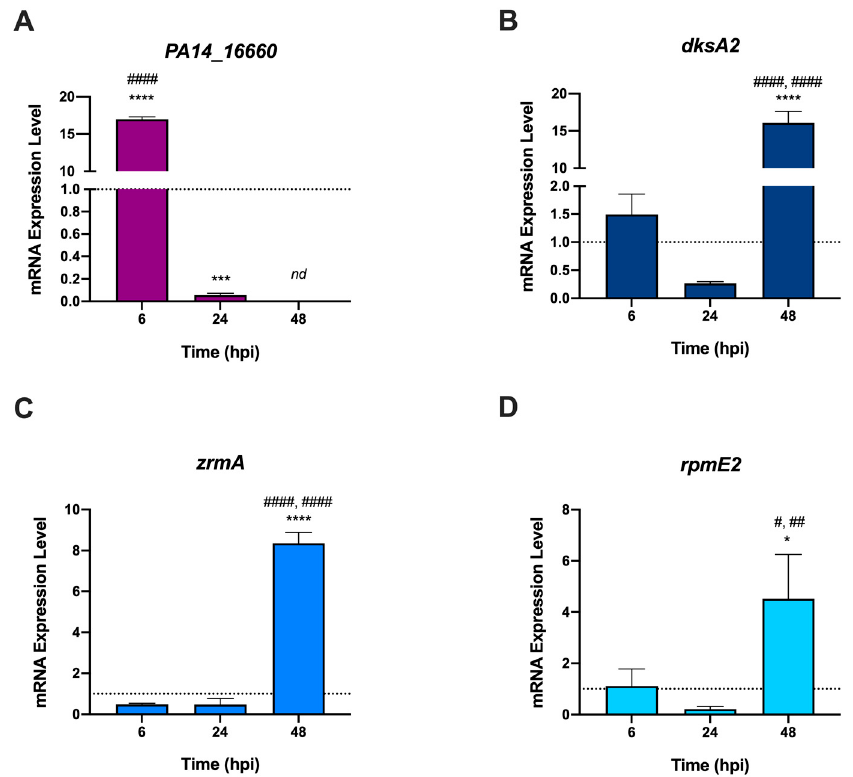
Figure 4. Expression levels of P. aeruginosa genes from infected zebrafish. RT-PCR was performed on bacterial mRNA extracted from zebrafish at 6, 24, and 48 hpi. The dotted line at Y = 1 represents the expression level of the genes in bacteria grown in LB medium (control). Data are means ± SD of three independent experiments, and statistical analyses were performed by ordinary one-way ANOVA and Bonferroni’s multiple comparison test. Asterisks show statistical differences versus bacteria grown in LB medium (**** p < 0.0001; *** p < 0.0005; * p < 0.05), hash signs show statistical differences between samples at the different hpi (#### p < 0.0001; ## p < 0.001; # p < 0.05); nd: not detected.